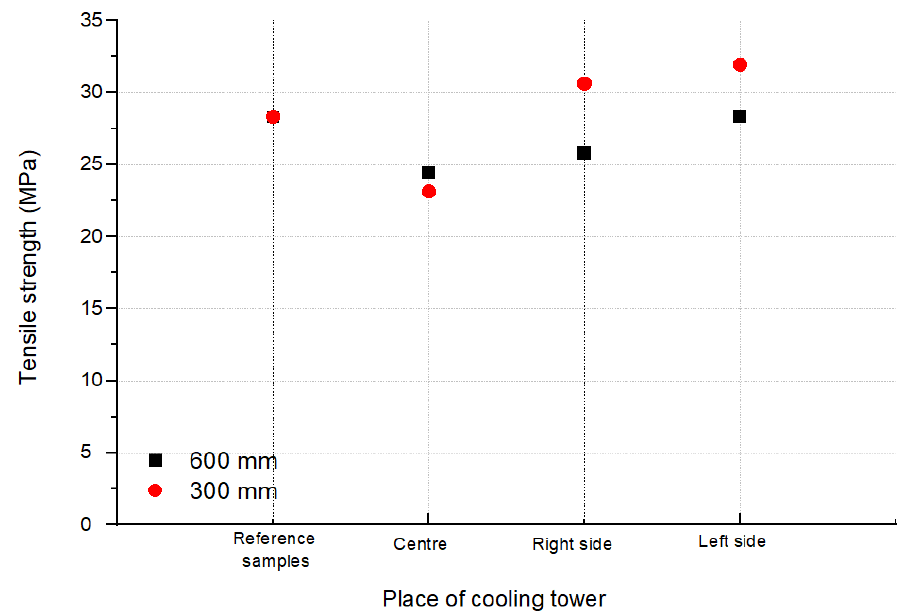
Figure 9. Tensile strength from block positions according to Figure 2 for CT1.